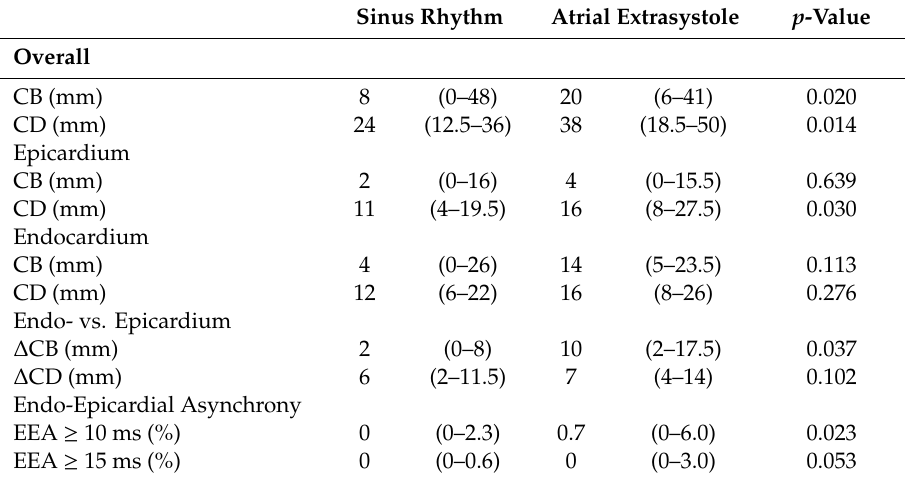
Table 1. Conduction disorders during sinus rhythm vs atrial extrasystole.